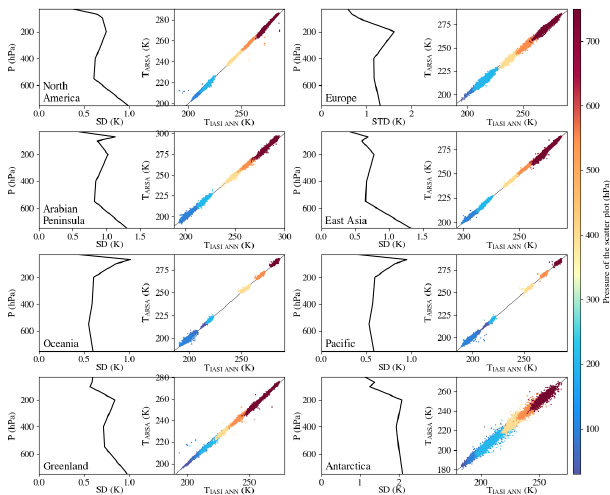
Figure 8. Standard deviation profiles of the differences between IASI-ANN and ARSA temperatures (left of each subplot) and cor- relation between the two datasets (right of each